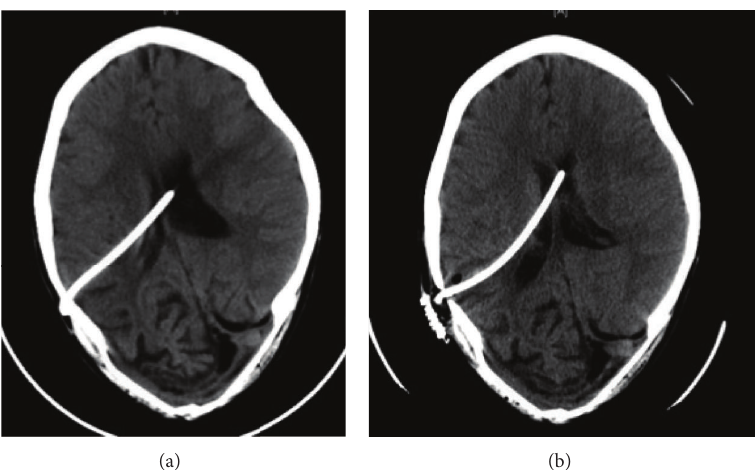
Figure 1: Computed Tomography of the brain demonstrating dilated ventricular system as a sign of ventriculoperitoneal shunt malfunction (a) and the reduction in ventricular size after VP shunt revision (b).